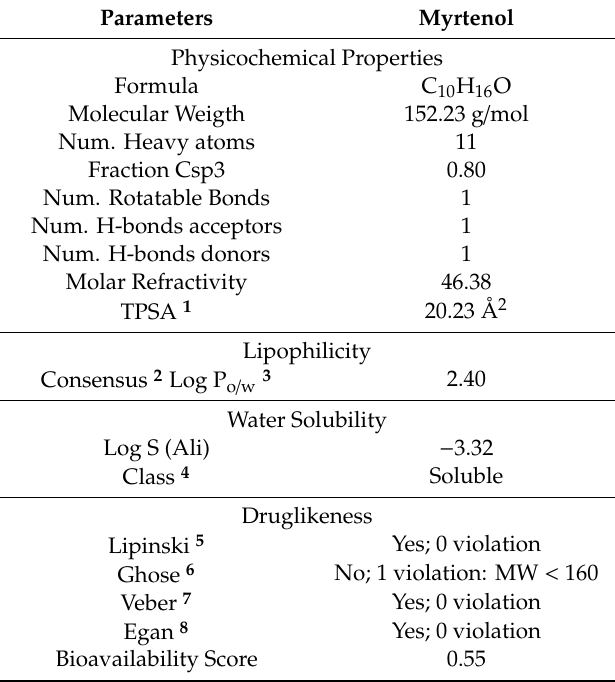
Table 3. In silico studies of Lipinski’s parameters of